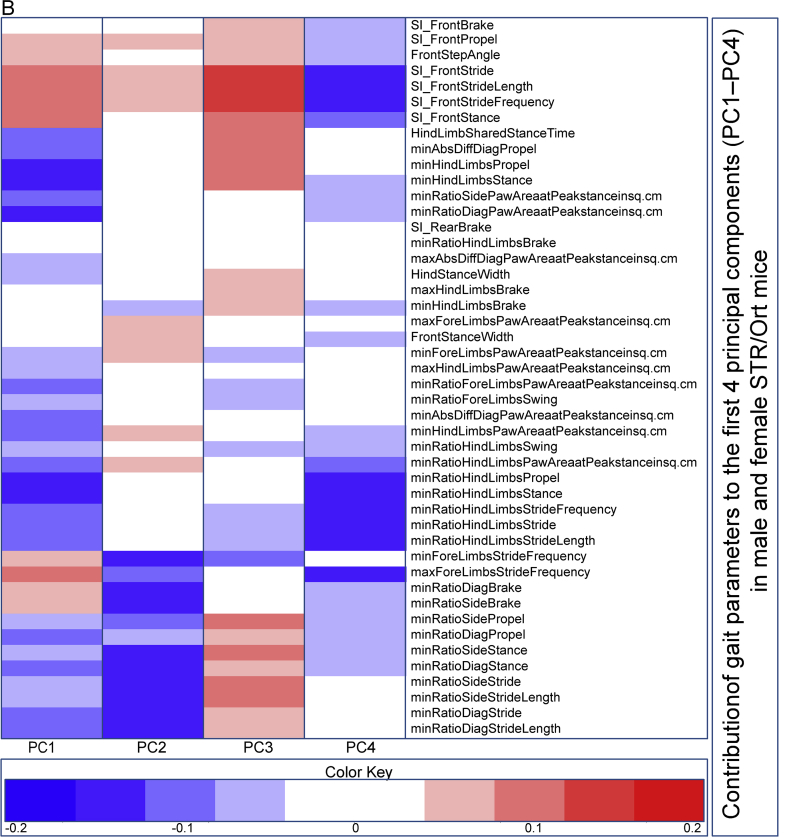
Sexually dimorphic OA development in STR/Ort mice is linked to longitudinal gait asymmetry. (A-B) Heatmaps representing the contribution of the gait parameters to the first 4 principal components (PC1–PC4) in male and female STR/Ort mice